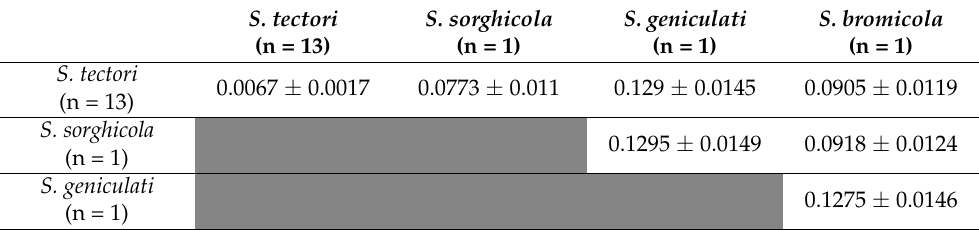
Table 2. Matrix of pairwise K2P distances within Stenodiplosis tectori n. sp. and between Stenodiplosis tectori n. sp. and the other three congeners ( S. bromicola , S. sorghicola and S. geniculati ). Data are expressed as the mean ± S.E. Grey background = not